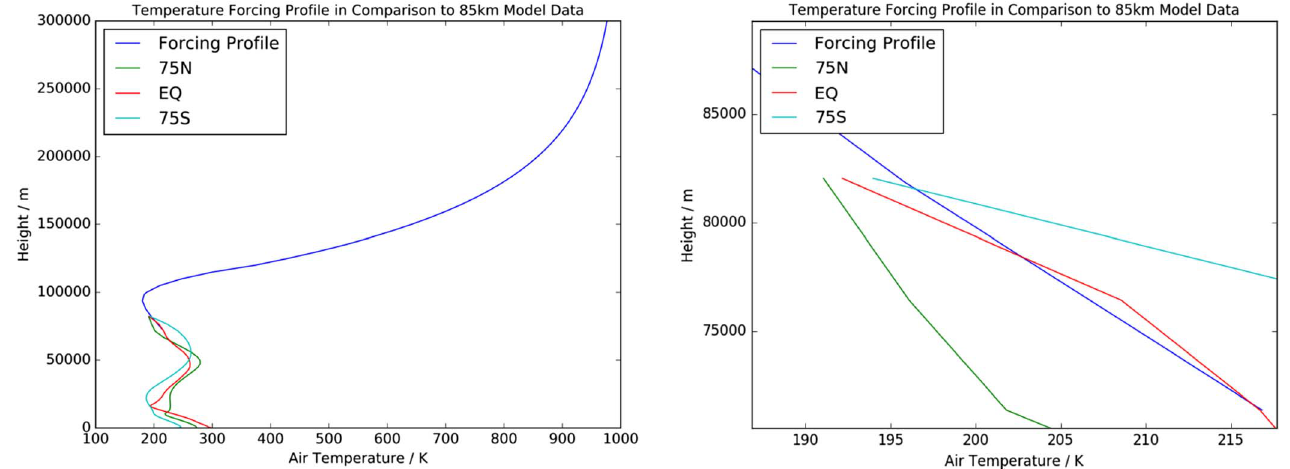
Fig. 9. Comparison of the 85 km temperature fi eld for various latitudes and the forcing pro fi le (a), with pertinent area zoomed in (b). Good agreement between the two is